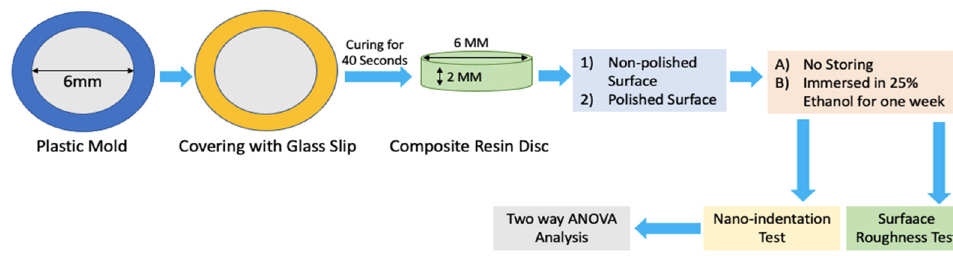
Figure 1. Schematical Specimens Preparation.